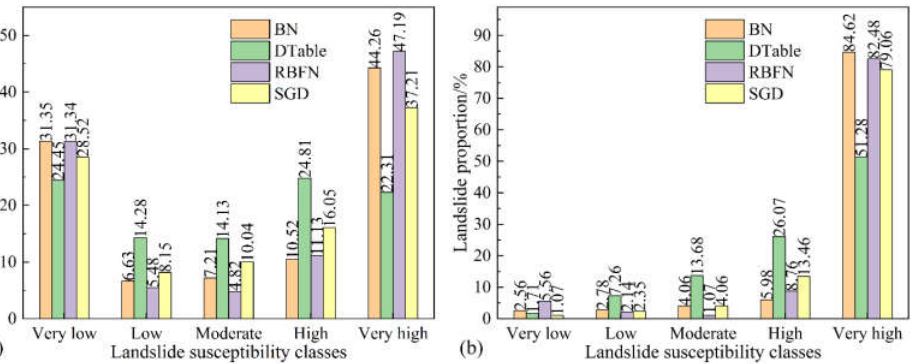
Figure 11. Quantitative analysis of the landslide susceptibility maps within a 1 km buffer zone along the DS railway. ( a ) Area proportion of susceptibility classes. ( b ) Landslide proportion in each susceptibility class.